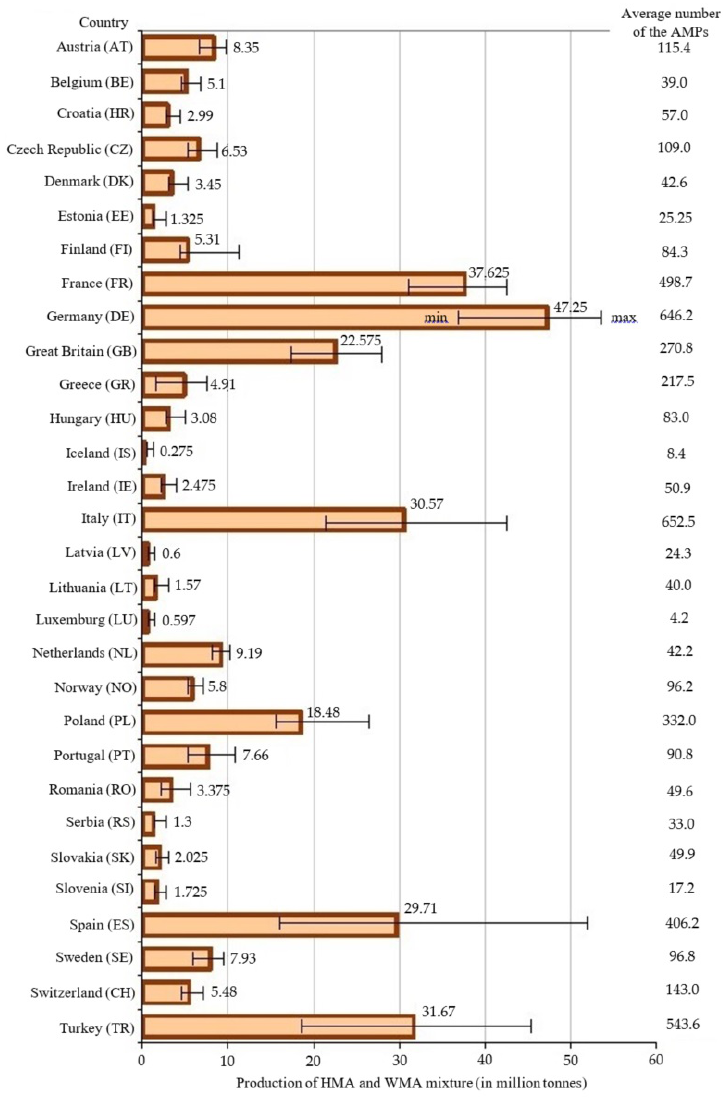
Figure 3. The average, maximum and minimum values of the produced quality HMA and WMA mixture in the European countries for the period of 12 years (2005 to 2016) and the average annual number of the operating AMPs.